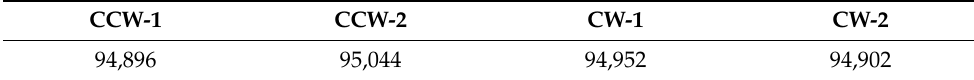
Figure 4. Mesh model; ( a ) UAV; ( b ) Greenhouse. Table 3. Number of rotor grids. Table 3. Number of rotor grids.